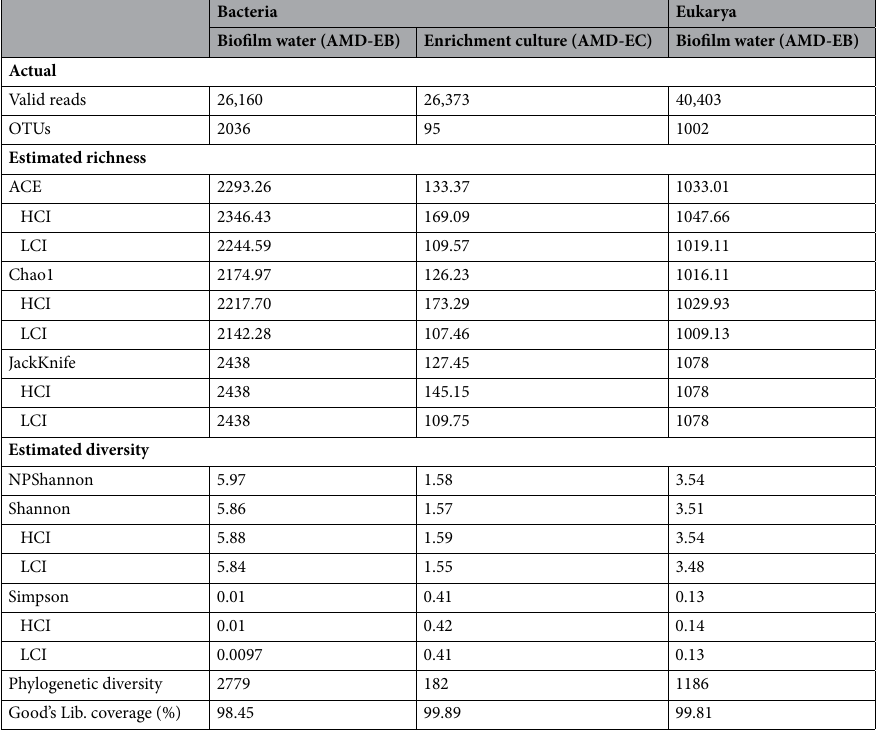
Table 2. Alpha diversity of microbiome evenness, richness and varieties of species in the sediments. Clustering of OTUs found was achieved with UCLUST and the open reference method as all taxa were selected for analysis. HCI High Confidence Interval (95%), LCI Low Confidence Interval (95%), OTUs Operational taxonomic units determined at